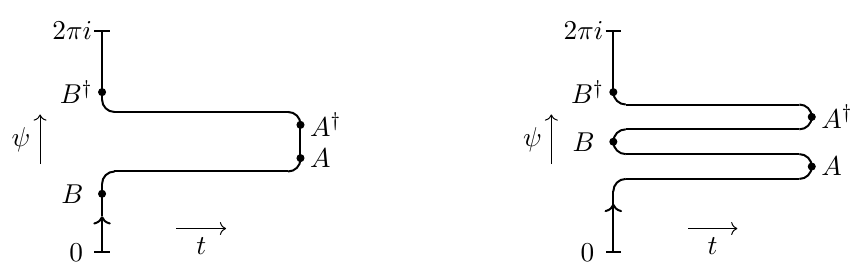
Figure 6 . The TOC and OTOC contours. The imaginary time direction is